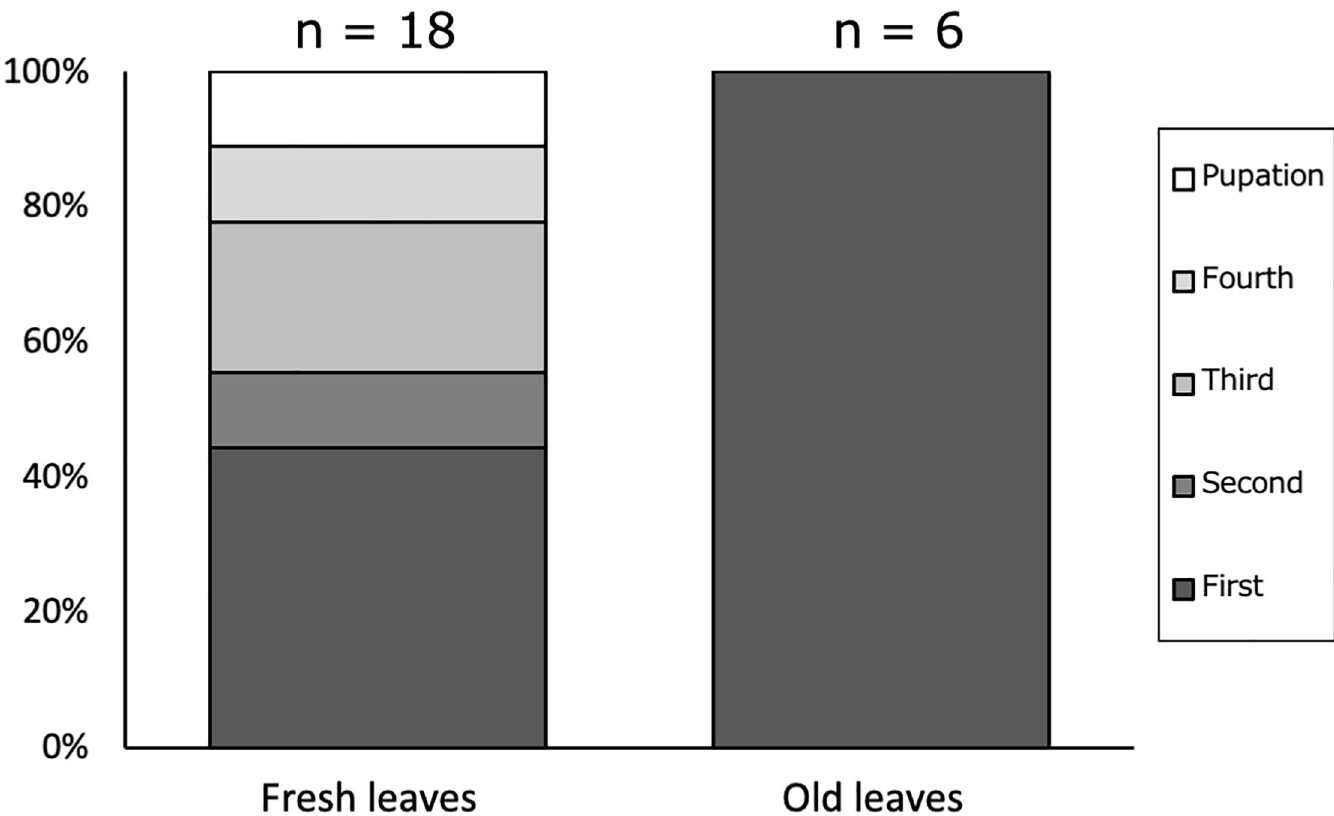
Fig 4. Larval survival of laboratory-reared A . bazalus fed fresh or old L . edulis leaves. First–Fourth: Larvae died at the respective instars; Pupation: Larvae successfully